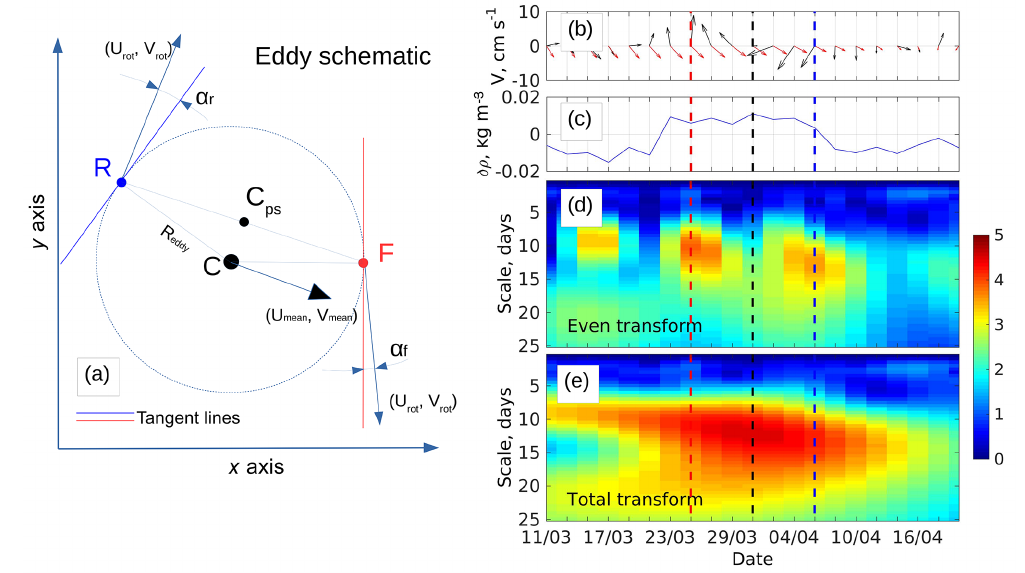
Figure 3. (a) Schematic of an idealized eddy on a horizontal plane. F, R, C, and C ps points indicate the frontal and rear edges and the “true” and “pseudo” centers of an eddy, respectively. U mean and V mean are the velocity components of the low-frequency current. U rot and V rot are the rotational velocities at the frontal and rear edge of the eddy. α f and α r are angles between the vector of rotational currents and tangent lines at the frontal and rear borders of the eddy. An FR segment shows the trajectory by which the eddy passes through the mooring. Also shown are (b) vectors of rotational (black) and mean (red) current, (c) density anomalies, and (d) even and (e) total wavelet transformations of velocities from the MMP instrument in the Atlantic Water temperature core (254m) at mooring M1f during the passing of a cyclonic eddy in March–April 2009. The frontal and rear eddy edges identified by even wavelet transformations are marked by red and blue dashed vertical lines, whereas the black vertical line associated with the maximum of the total wavelet transformation shows the time when the eddy “pseudo” center was at the mooring site. All wavelet transforms are in units of normalized